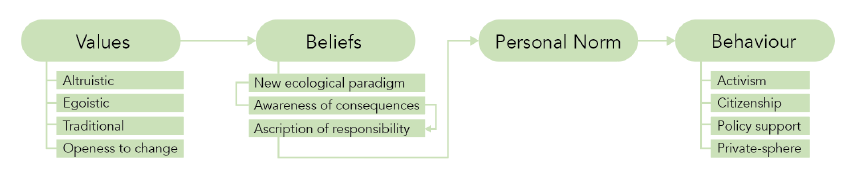
Figure 2. The Value-Belief-Norm theory of behaviour